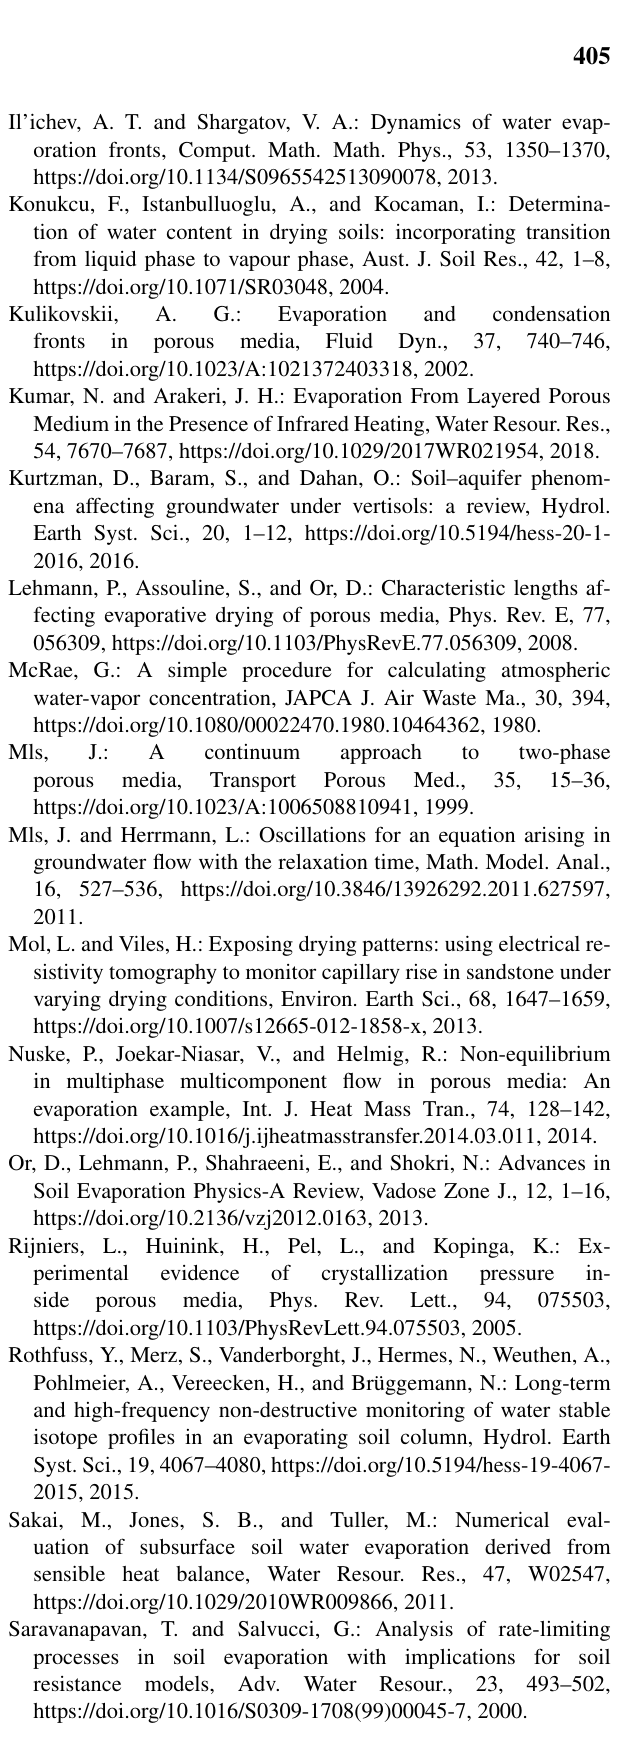
Origin of honeycombs: Testing the hydraulic and